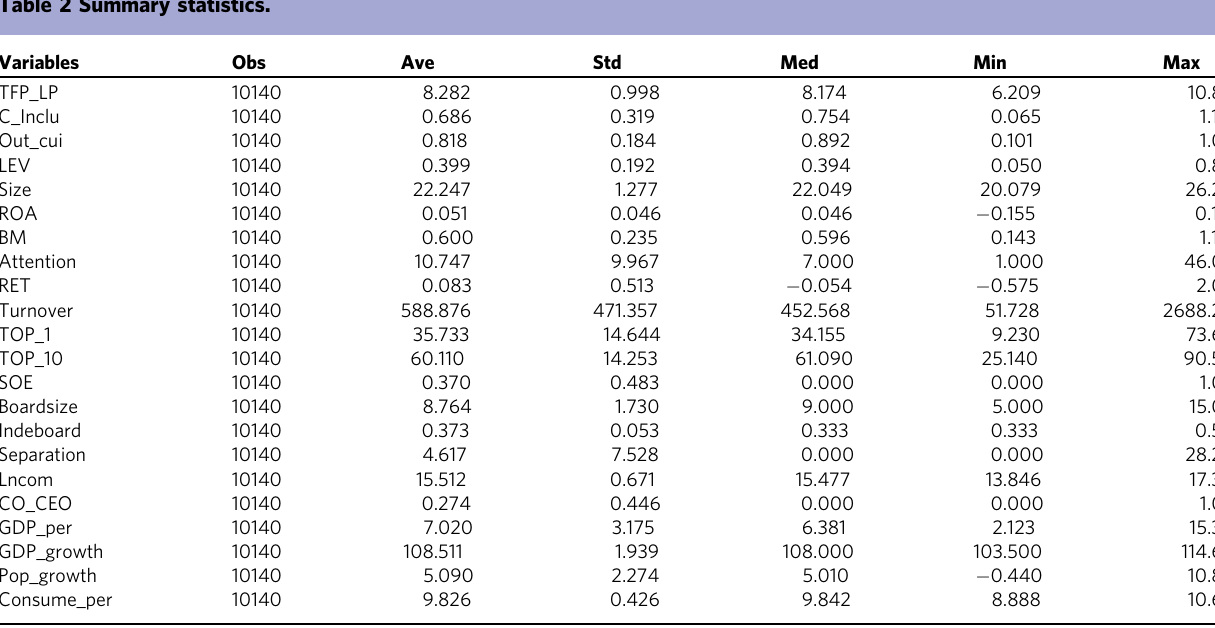
Fig. 2 Distribution of Cultural Inclusion. The more inclusive areas correspond to darker purple. Table 2 Summary